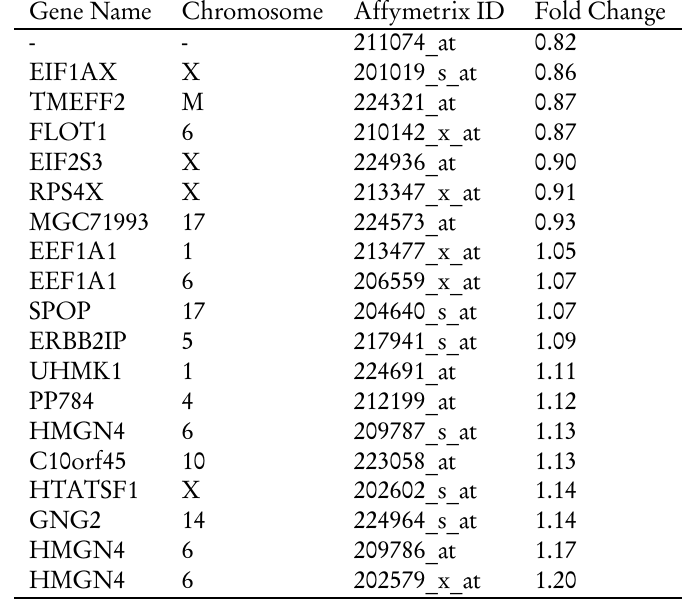
19 probes found to be significantly differentially expressed according to gender by Karlovich et al. (2009), with a mean log-transformed signal intensity greater than or equal to